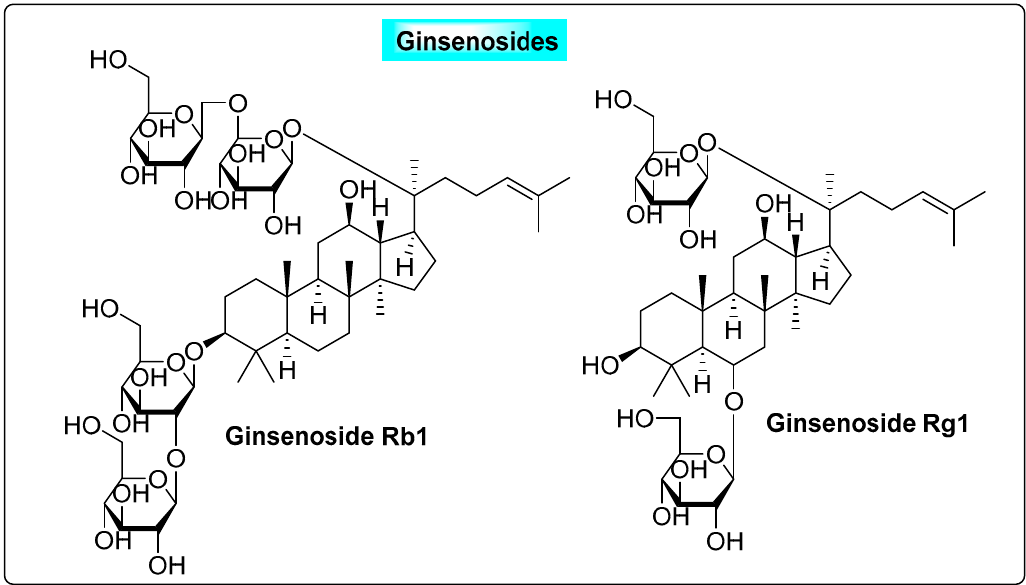
Figure 14. Useful anti-PCOS ginsenosides present in Panax ginseng .